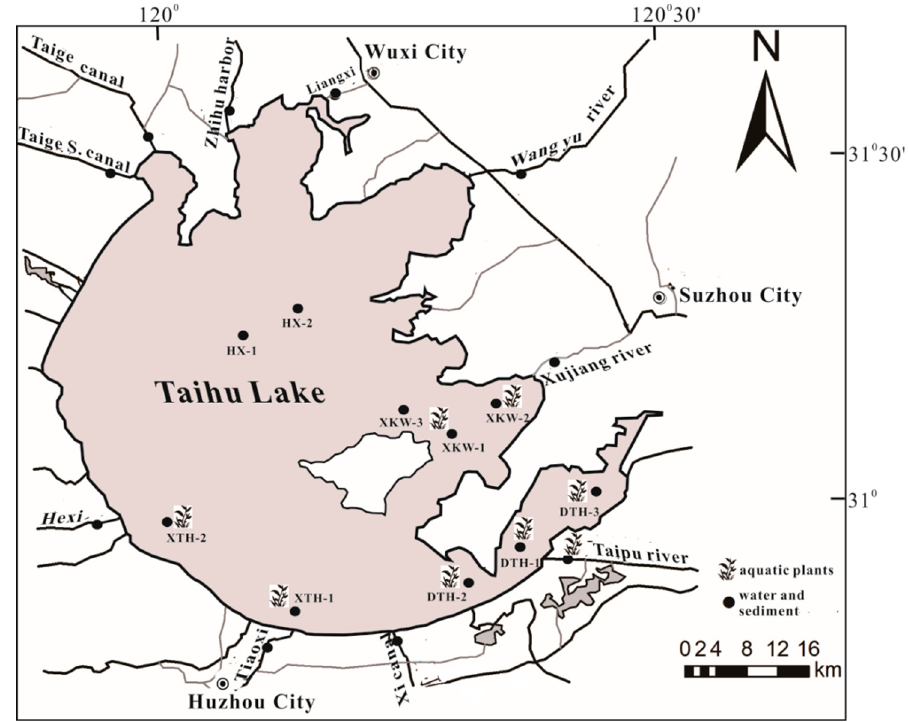
Figure 1. Sampling sites in Taihu Lake and its surrounding rivers.